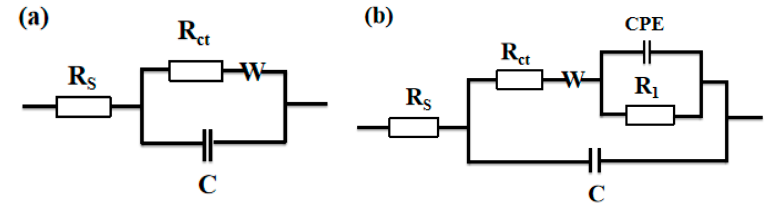
Figure 5. The equivalent circuit diagram of CO 2 in [Bu 4 N]BF 4 /PC ( a ), [Bmim]BF 4 /PC ( b ) electrolyte. R s is the solution resistance, R ct is the charge transfer resistance, C is the double layer capacitance, W is the Warburg impedance, R 1 is the migration resistance of CO 2 through the ionic liquid adsorption layer, and constant phase element (CPE) is the constant phase element.